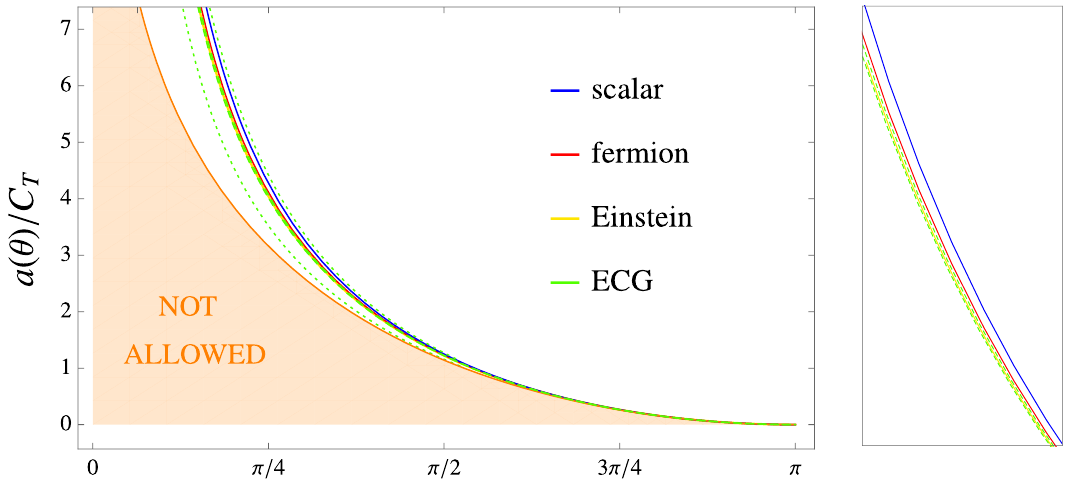
Figure 1 . We plot the corner functions (normalized by their respective charges C (blue), a free fermion (red), holographic Einstein gravity (yellow) and holographic Einsteinian cubic gravity (green). For the limit value µ ’ 0 . 00312 corresponding to t 4 = +4 (see discussion below), the curve lies very close but slightly below the Einstein gravity result (green dashed line). The case µ ’ − 0 . 00322 corresponding to the other limit value ( t 4 = − 4 ) lies even closer but slightly above the Einstein gravity curve and just below the fermion one. The right plot is a zoom of the curves between θ = π/ 4 and θ = 3 π/ 8 . The orange region in the left plot is excluded for general theories by the inequality eq. (5.94). The green dotted curves correspond to the values µ = − 0 . 05 (upper curve) and µ = +0 . 05 (lower curve) which we have included (only) in the left plot for visual